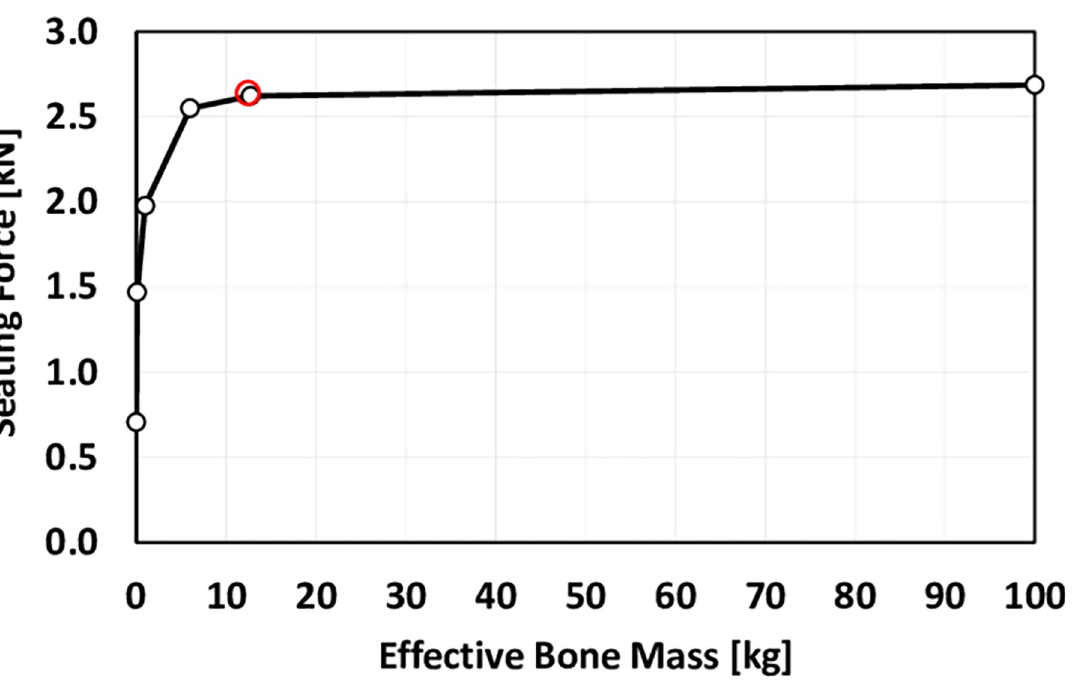
Fig 10. The implant seating force is plotted for the effective bone mass. The nominal condition tested is shown circled, according to published data [16] and results in a maximum seating force. This decreases for effective bone masses of less than the nominal value.